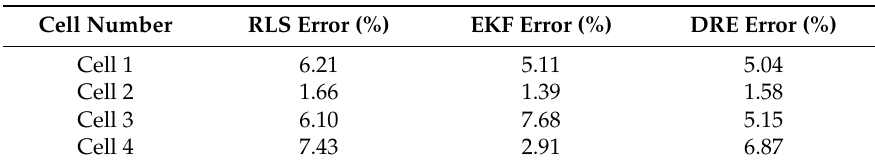
Table 2. Comparison of the average percent error from DRE algorithm, RLS algorithm, and EKF algorithm for a battery pack maintained at 20 °C.